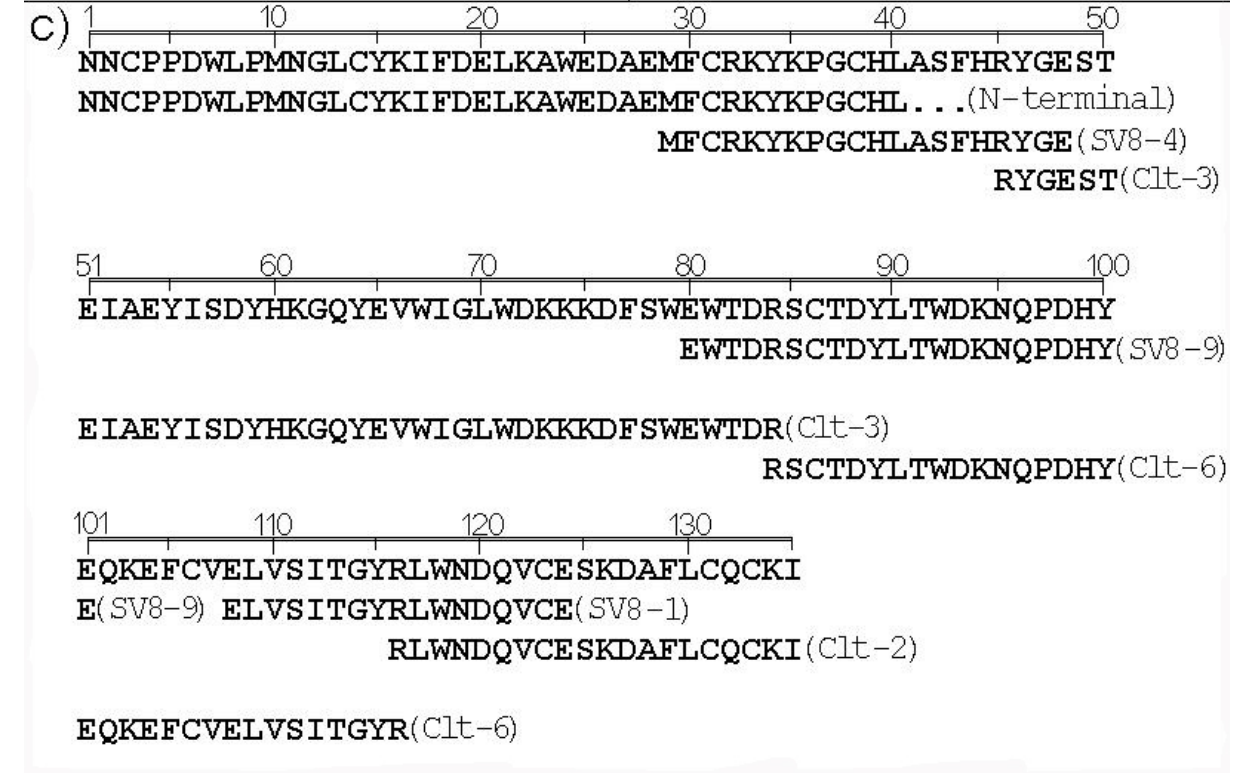
Figure 3. BmLec proteins were treated with ( a ) protease V8 (SV8) and ( b ) clostripain (Clt). In both cases, the peptides obtained were purified using an analytical reverse phase HPLC. The complete amino acid sequence of BmLec was determined by overlapping the N-terminal amino acid sequence of the reduced and carboxymethylated BmLec with other peptides. ( c ) Among them, the most important for the complete amino acid sequence determination were SV8-4; SV8-9, SV8-1, Clt-3, Clt-2 and